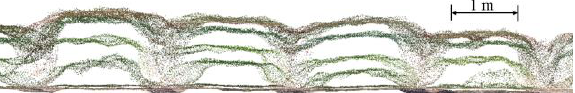
Figure 2. Multi temporal UAV point cloud. Side